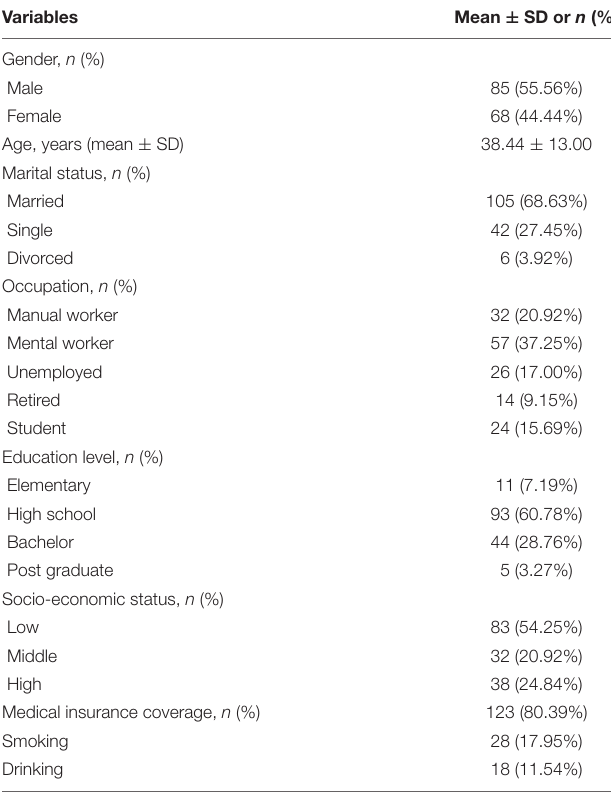
TABLE 1 | Demographic characteristics of CD patients included in the